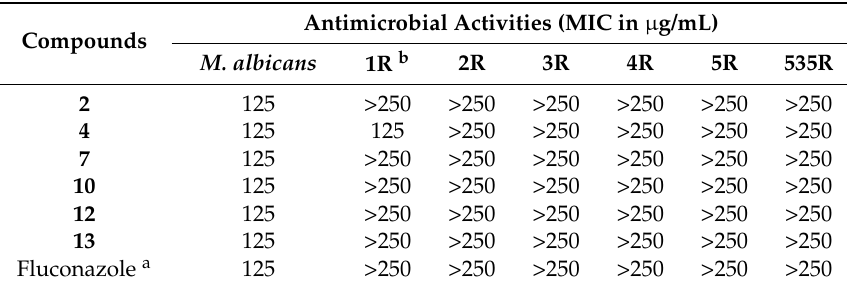
Table 3. Antimicrobial activities of compounds 2 , 4 , 7 , 10 , 12 and 13 .